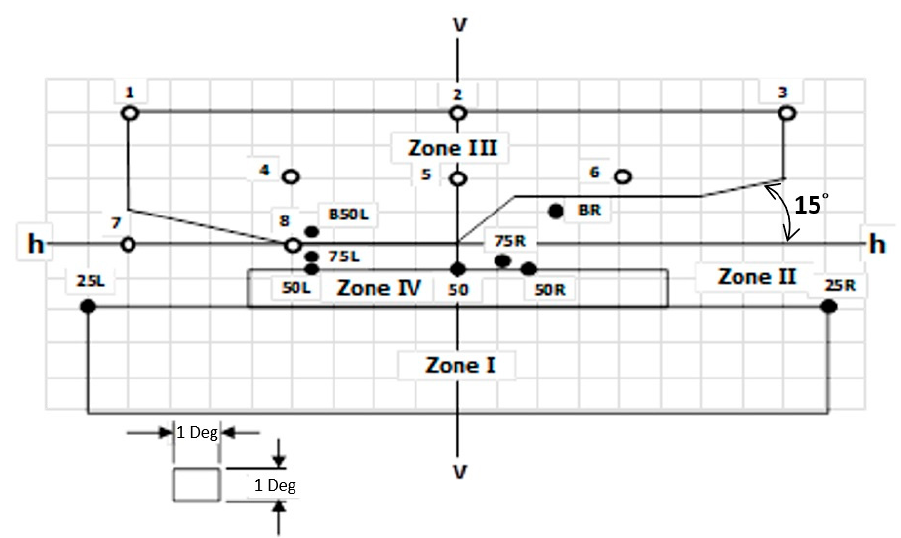
Figure 5. Location of each test point for a low beam under European law. Table 2: ECE R-112 low-beam test specification .